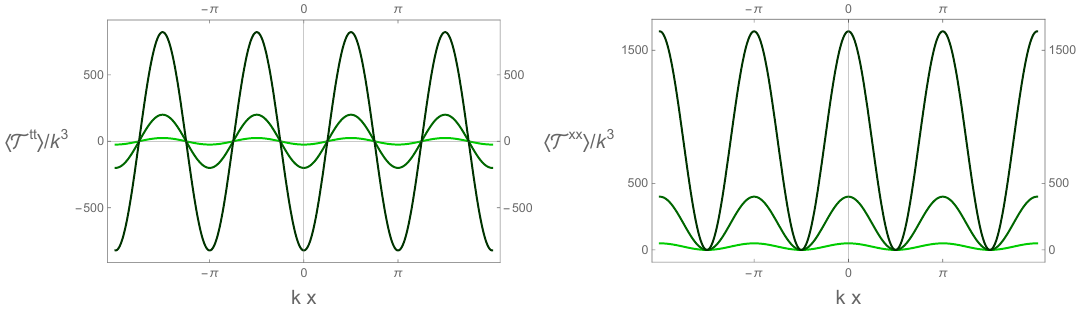
Figure 1 . The one-point functions of the stress energy tensor hT tt i = (cid:0)hT yy i and hT xx i for boomerang RG (cid:13)ows driven by deformations with (cid:3) =k (cid:25) 3 : 5 ; 10 : 0 ; 20 : 3 (lightest to darkest). The spatially averaged energy density vanishes in these (cid:13)ows, hT tt i = 0.